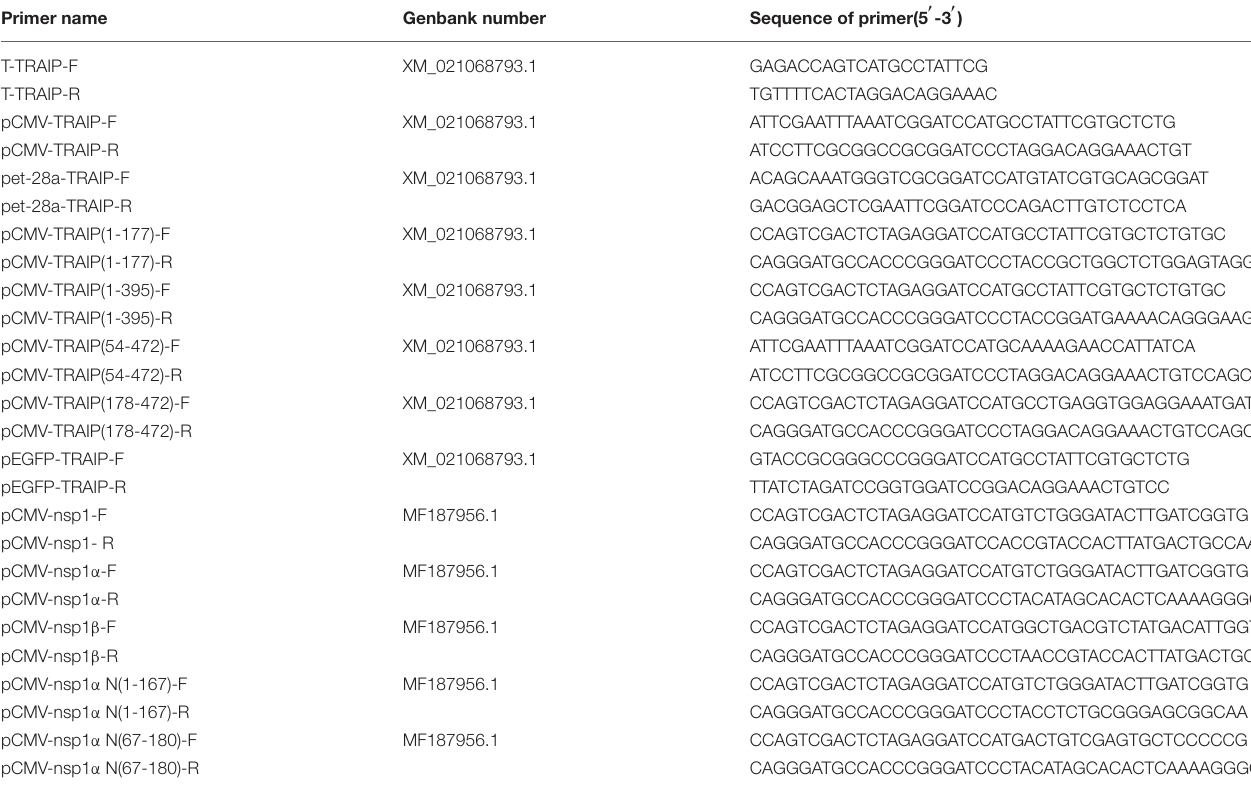
TABLE 1 | Primers used for PCR amplification.